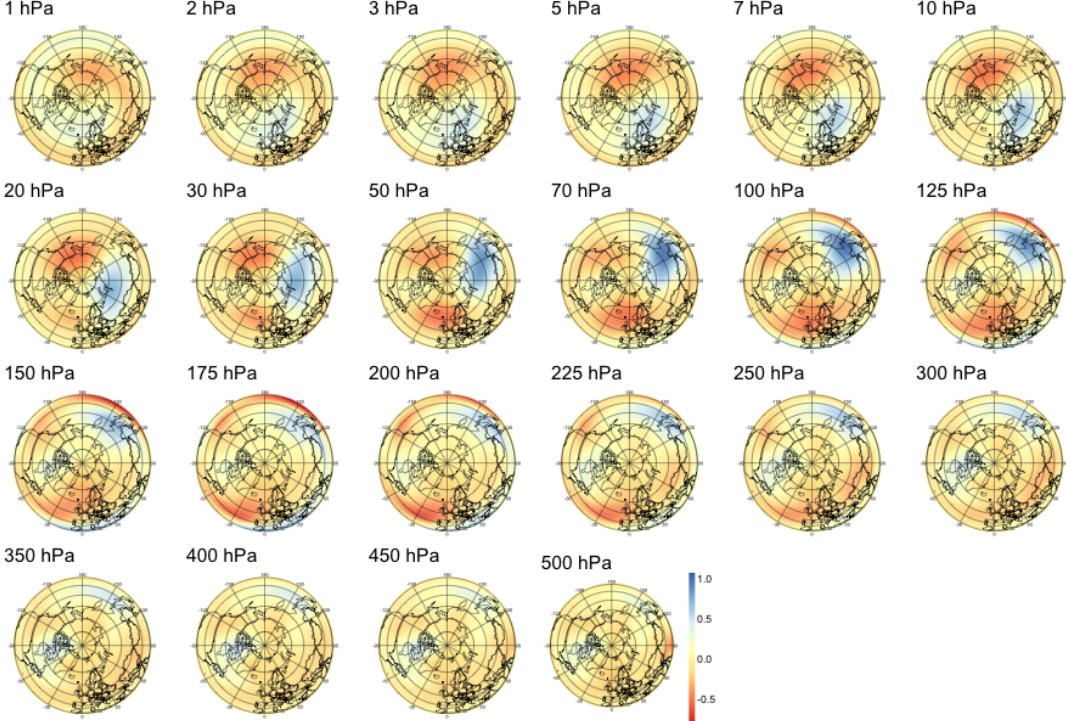
Figure B6. Pattern of PV waves maximizing correlation with the SSW index at a lead time of 6h.